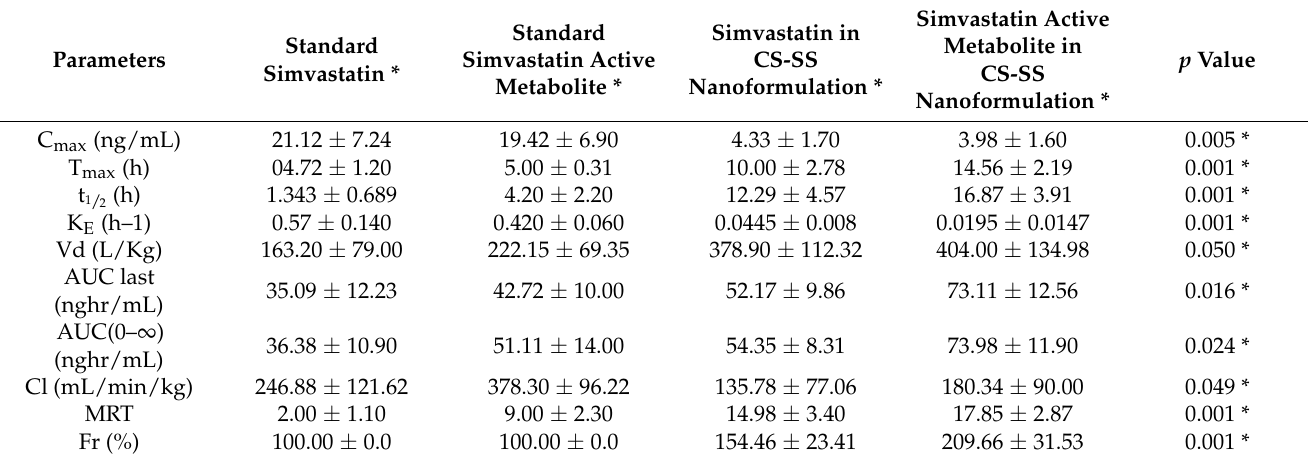
Table 4. Pharmacokinetic parameters of simvastatin and simvastatin acid (metabolite) in pure drug and